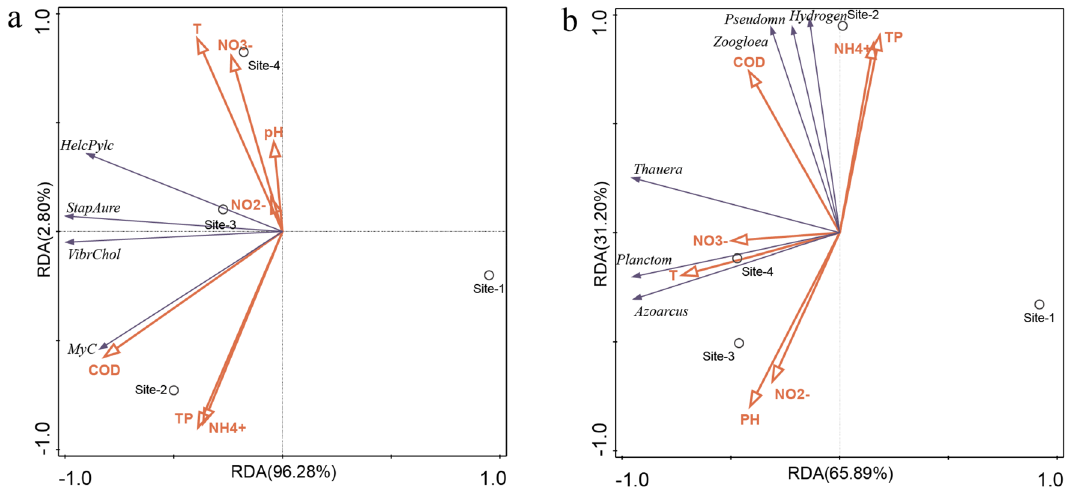
Figure 4. Redundancy analysis (RDA) of water quality parameters at the four sampling sites and their relationship to the microbial community structure of infectious pathogens ( a ) and functional bacteria ( b ).